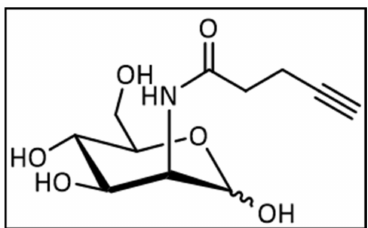
Figure 5. Structural formula of 2-( N -4-Pentynoyl)-2-Deoxy- D -Mannopyranoside.